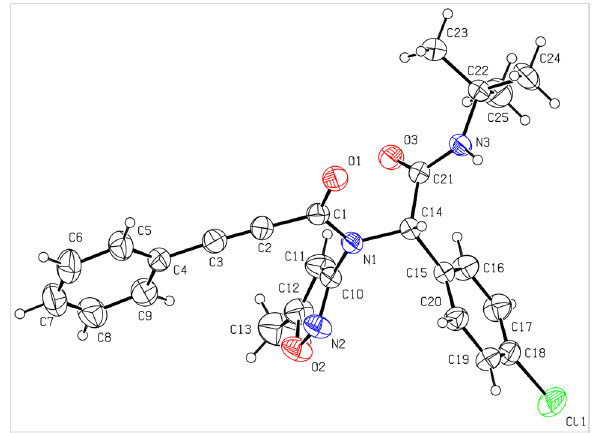
Figure 5: Molecular structure of N -(2-( tert -butylamino)-1-(4-chloro- phenyl)-2-oxoethyl)- N -(5-methylisoxazol-3-yl)-3-phenylpropiolamide ( 9e ) (X-ray diffraction data). Non-hydrogen atoms are presented as thermal ellipsoids with 50%